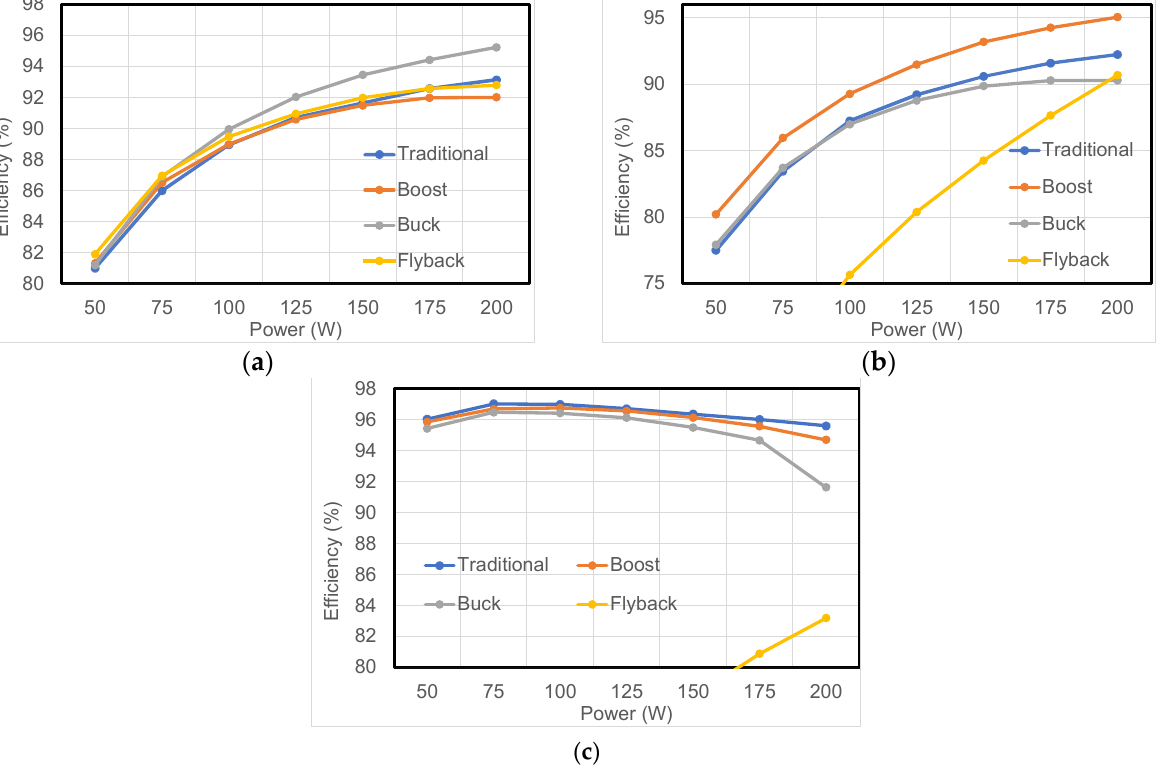
Figure 9. Efficiency results for: ( a ) M = 0.5, ( b ) M = 1, ( c ) M = 2.